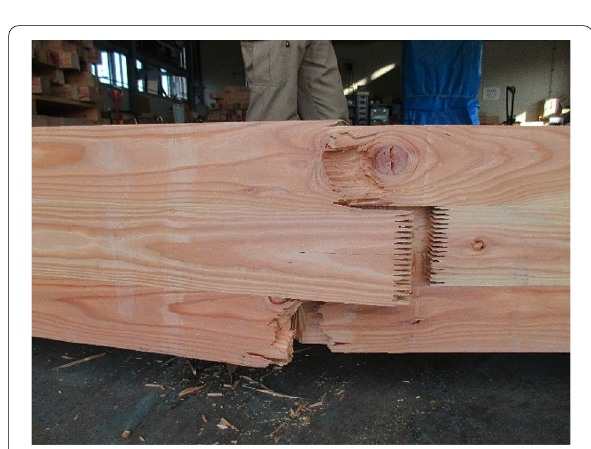
Fig. 5 Failure of a short-term loading test